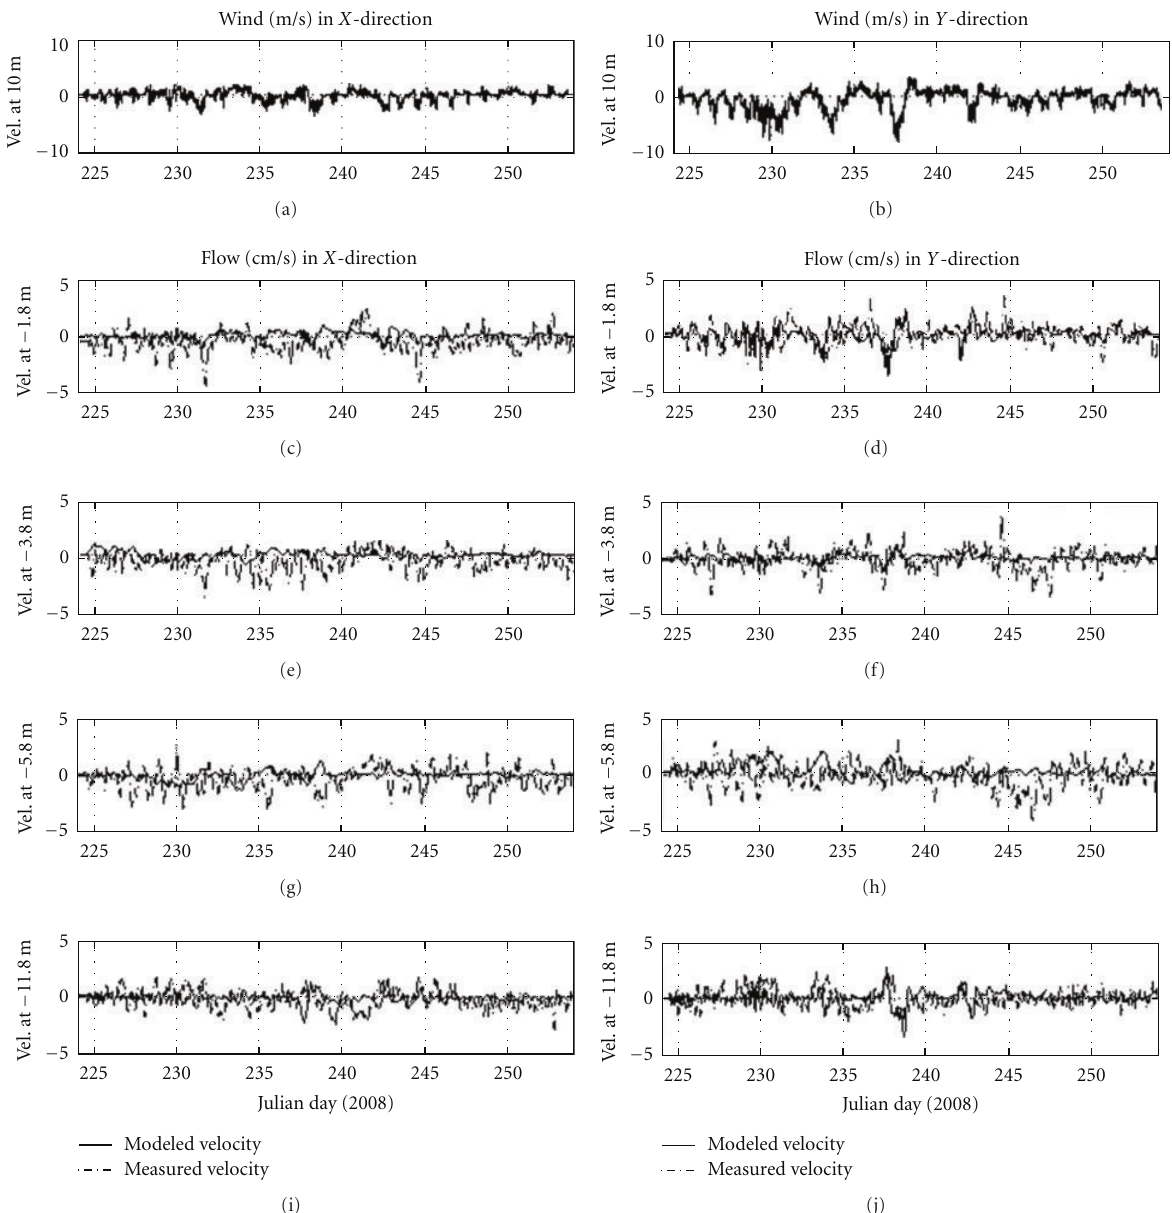
Figure 6: Comparison of the modeled and measured flow velocities at di ff erent water depths; the modeling results are from the simulation without the heat e ff ects on water